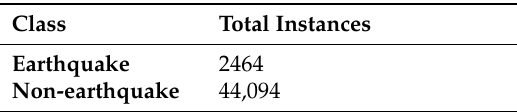
Table 6. Datasets used for model training and testing in a dynamic environment.